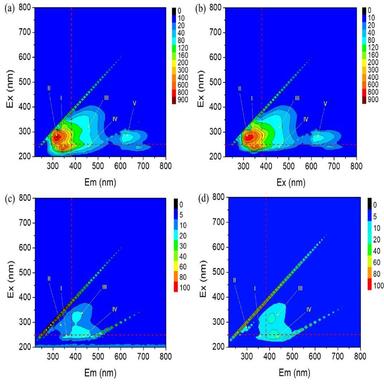
Fluorescence EEM spectra of (a) the raw IPWTP secondary effluents; (b) samples treated by BAF reactor; (c) samples treated by Fenton oxidation process; and (d) samples treated by the combined process (Fenton + BAF).